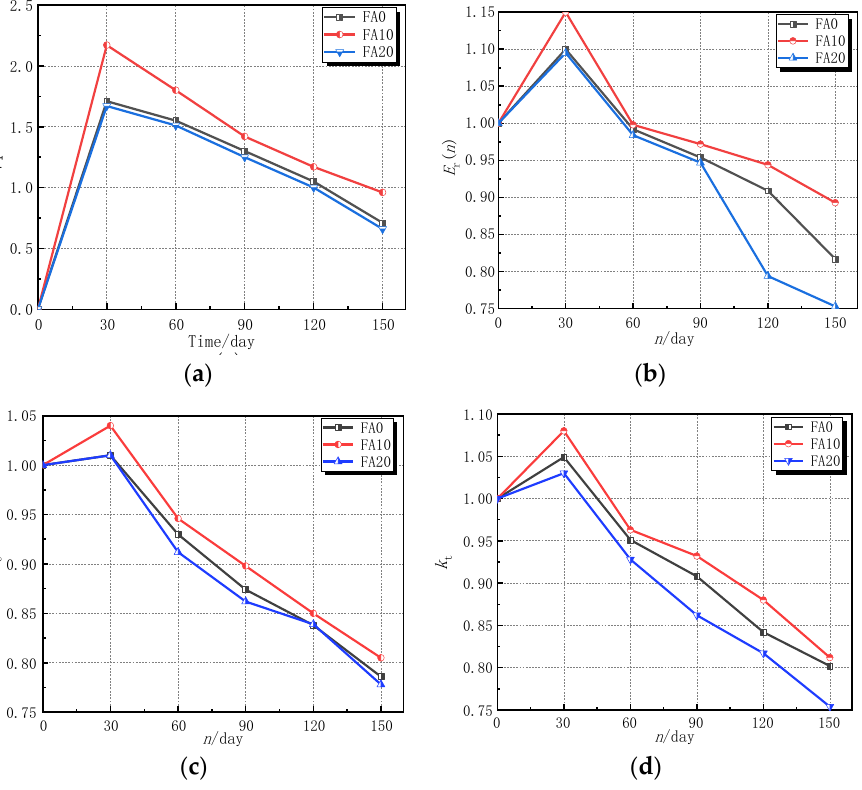
Figure 7. Testing results. ( a ) Variation of mass; ( b ) variation of E r ( n ); ( c ) variation of k c ; and ( d ) variation of k t .